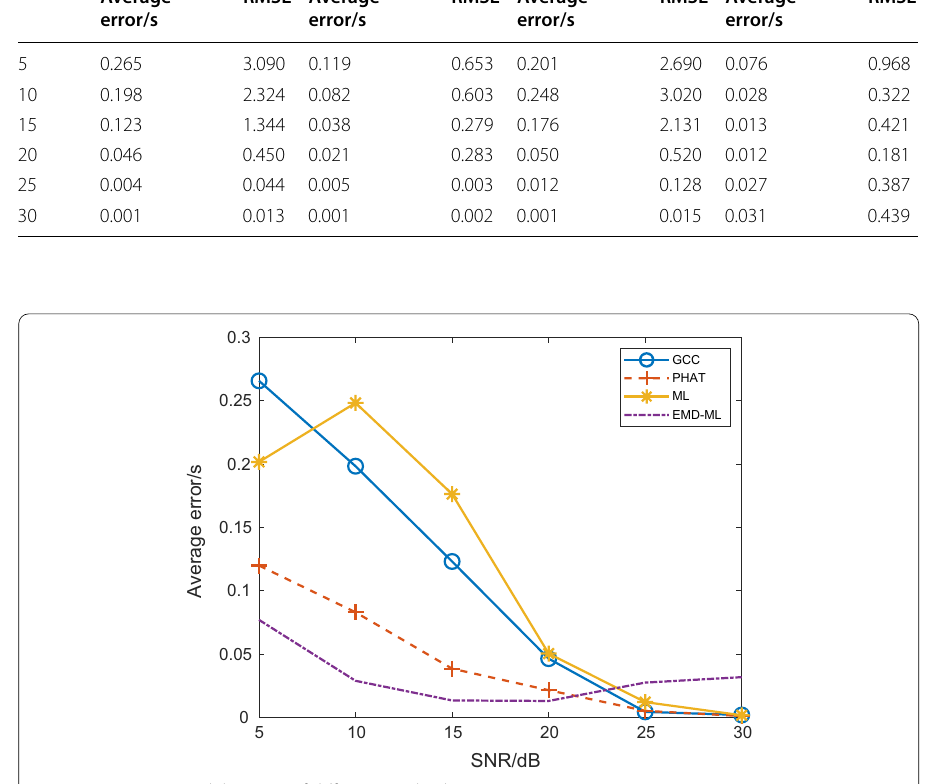
Fig. 8 Average time delay error of different